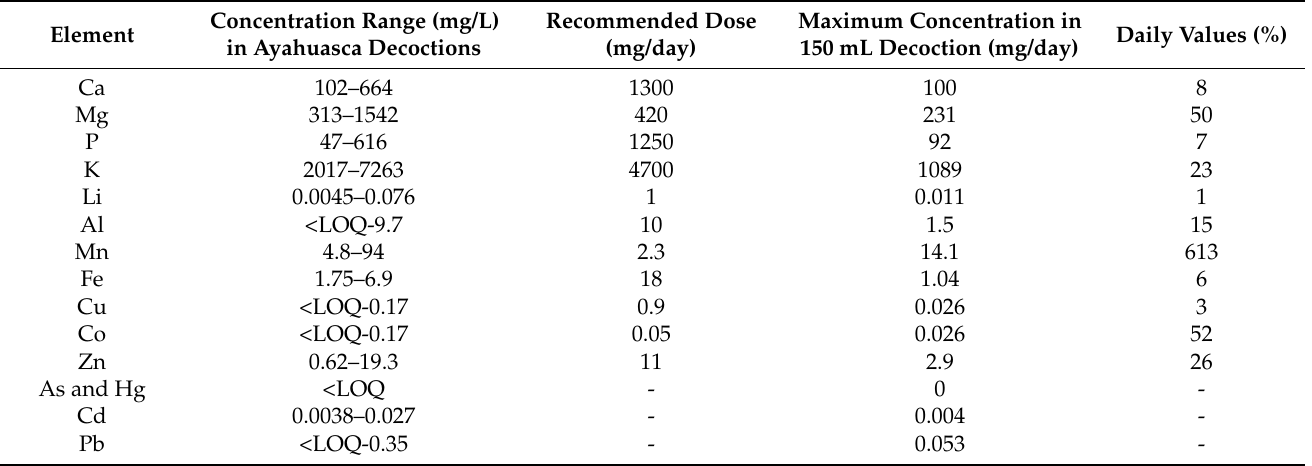
Table 2. Inorganic composition of ayahuasca decoctions. Daily values were calculated as a percentage of the maximum concentration in the decoction and recommended dose [35,36].